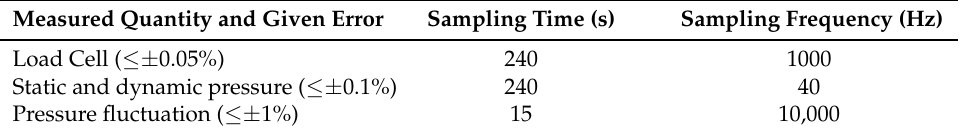
Table 1. Statistical convergence for a confidence level equal to 95% and given error on the mean values.